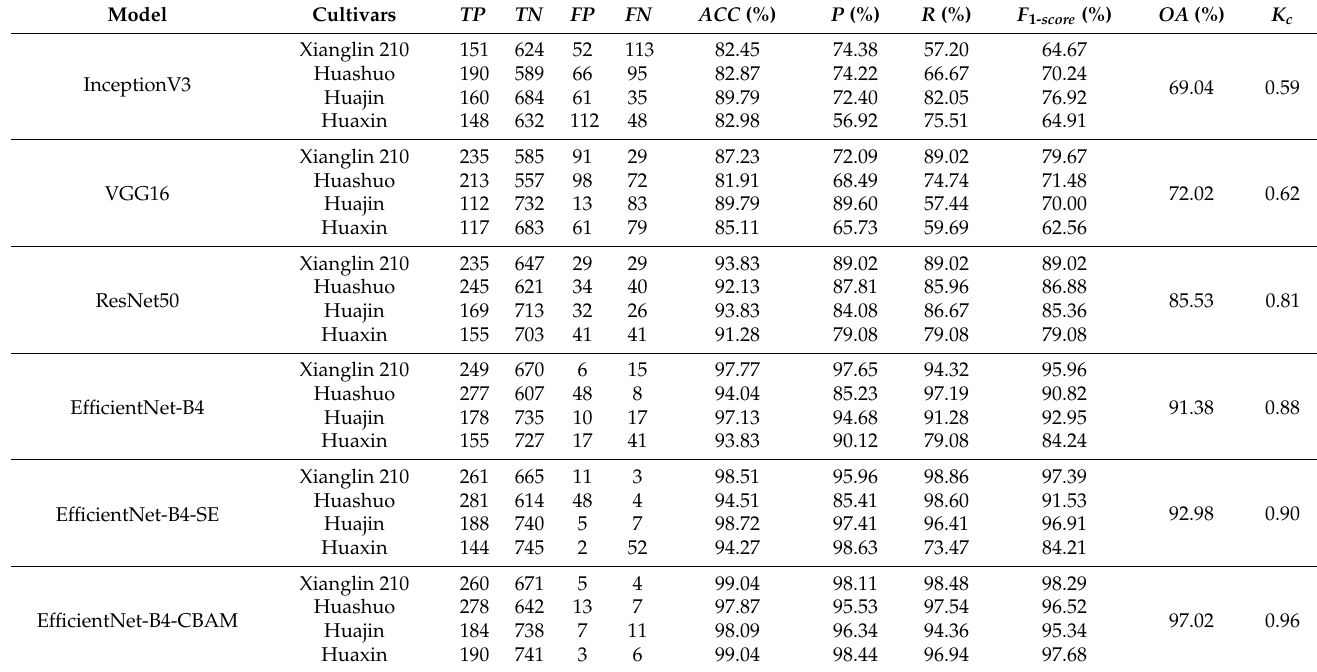
Table 3. Quantitative evaluation results of different